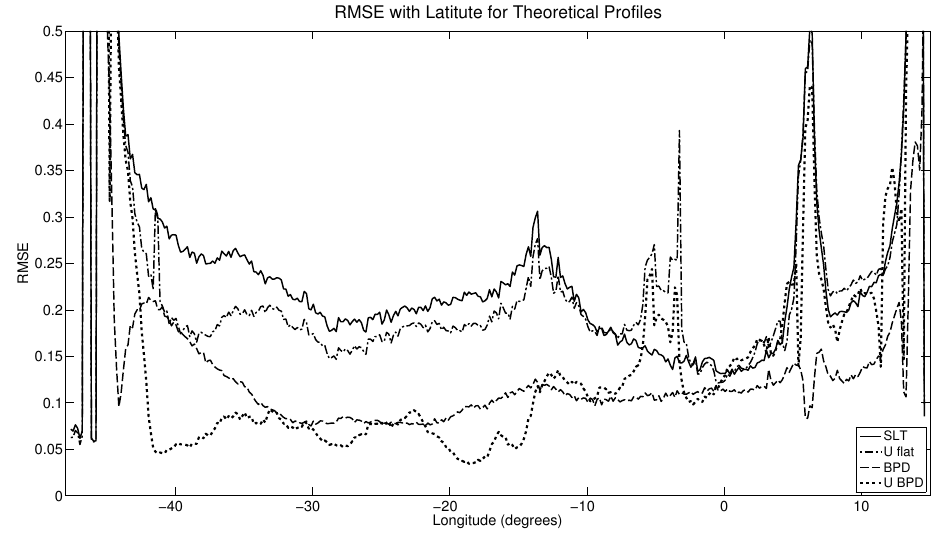
Fig. 10. The root mean square error of the theoretical sections compared to the mean model section as a function of